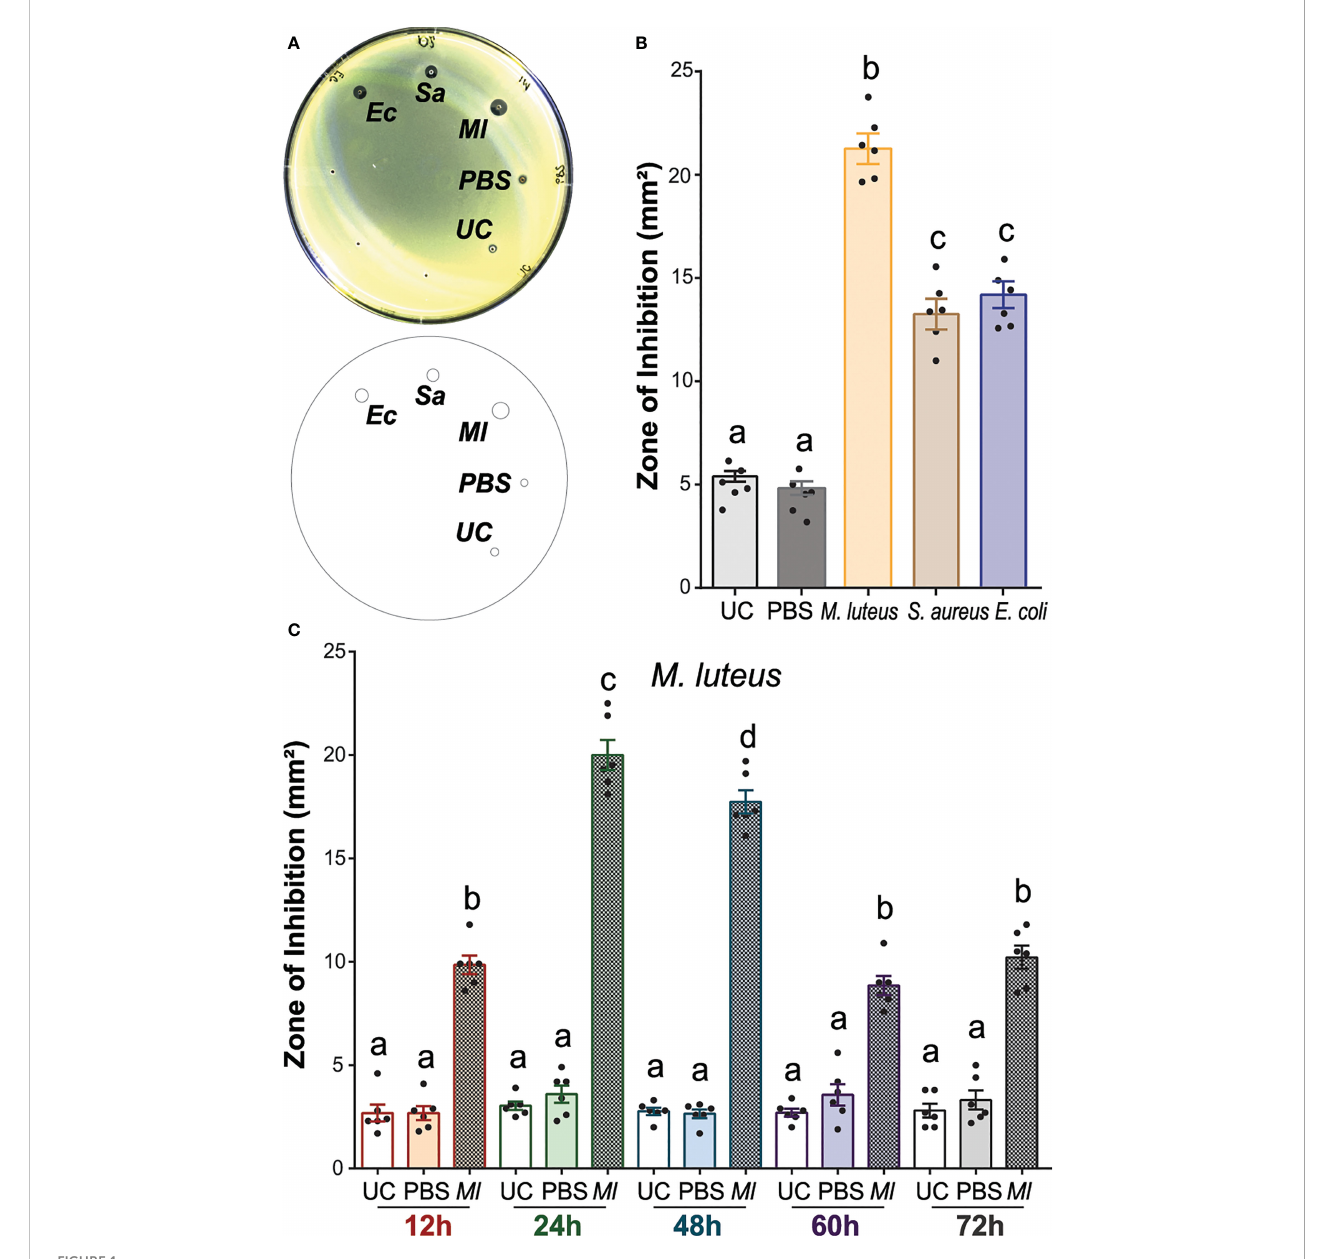
FIGURE 1 The antimicrobial activity of Anopheles gambiae hemolymph is induced by bacterial challenge. (A) Top: M. luteus -seeded plate showing the zone of inhibition (ZOI) produced by mosquito hemolymph collected 24 h after challenge with E coli , S. aureus , and M. luteus , respectively. The hemolymph of uninjected and phosphate-buffered-saline-injected mosquitoes acted as negative controls. Bottom: Drawing of the plate generated in Fiji is Image J to quantify the zone of inhibition (ZOI) for each treatment. (B) Zones of bacterial growth inhibition (mm 2 ) were measured using customized macros in Fiji is Image J (C) The temporal variation of antimicrobial activity induction with M. luteus challenge was determined by collecting hemolymph at 12, 24, 48, 60, and 72 h after challenge. The ZOI was then measured as in (B) . In (B) (C) , data are shown as means with ±1 standard error ( n = 6). One-way ANOVA, followed by Bonferroni ’ s multiple-comparison post-test, was performed to calculate the statistical signi fi cance ( P < 0.05). Means with the same letter are not signi fi cantly